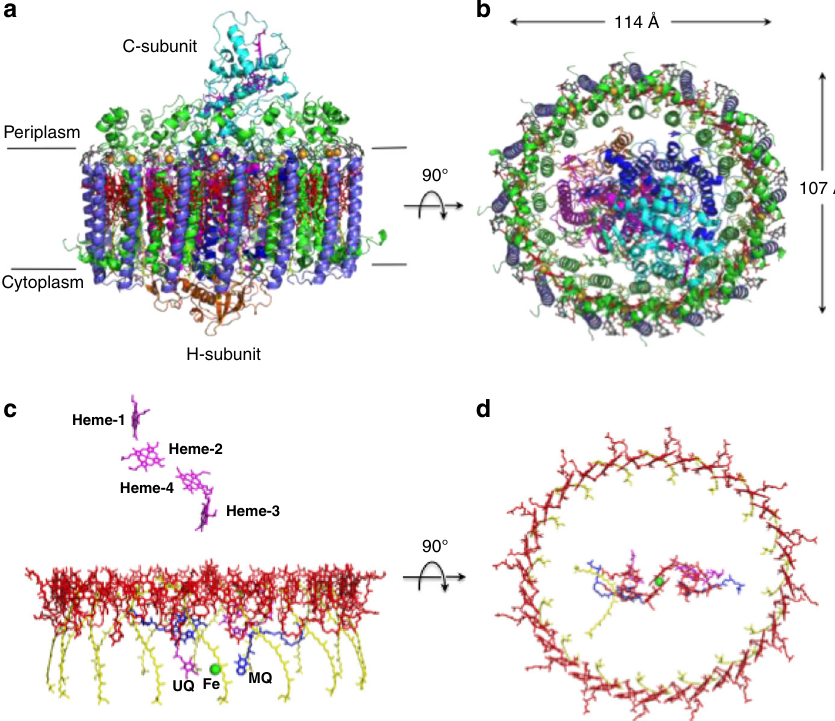
Fig. 1 Overall structure and cofactor arrangement of the Trv . strain 970 LH1-RC complex. a Side view of the LH1-RC parallel to the membrane plane with the periplasmic C-subunit above and the cytoplasmic H-subunit below. b Top view of the LH1-RC from the periplasmic side of the membrane. c Side view of the cofactor arrangement along the membrane plane with the periplasm above and the cytoplasm below. d Top view of the cofactor arrangement from the periplasmic side of the membrane. Hemes in the C-subunit are omitted for clarity. Color scheme: LH1 α , green; LH1 β , slate blue; L-subunit, magenta; M- subunit, blue; C-subunit, cyan; H-subunit, orange; Ca 2 + , gold ball; BChl a , red sticks; 3,4,3 ′ ,4 ′ -tetrahydrospirilloxanthin, yellow sticks; DDM, black sticks. Phospholipids are omitted for clarity. Cofactors in L- and M-subunits of RC are colored in magenta and blue,